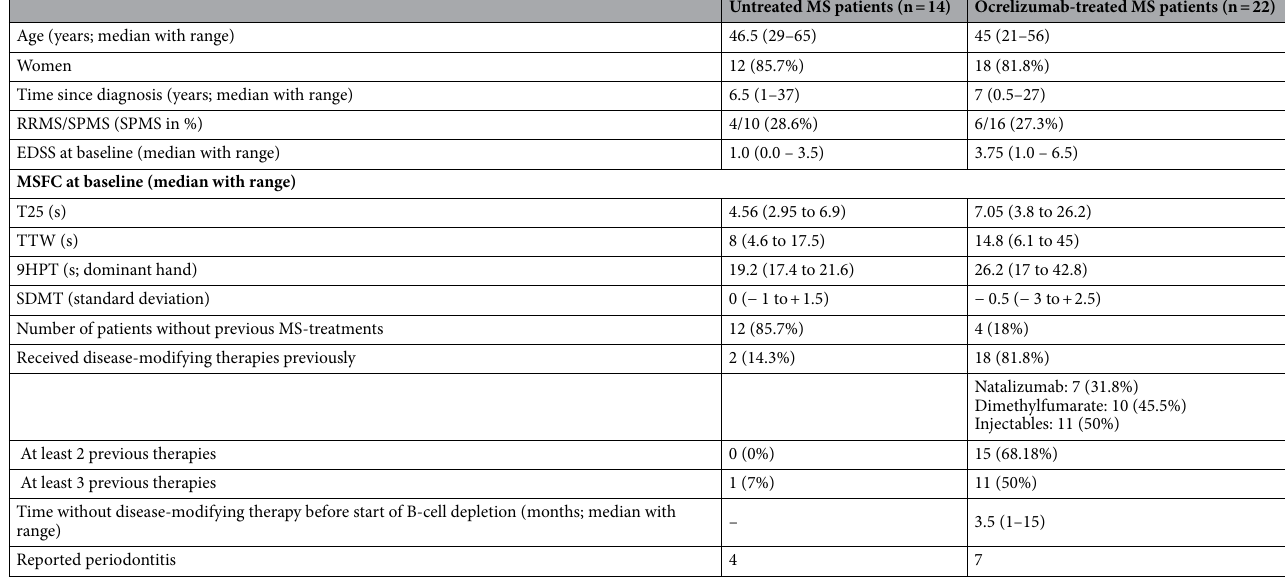
Table 1. Baseline characteristics in the untreated and ocrelizumab-treated MS patient cohort. Absolute numbers with percentages or range in brackets.